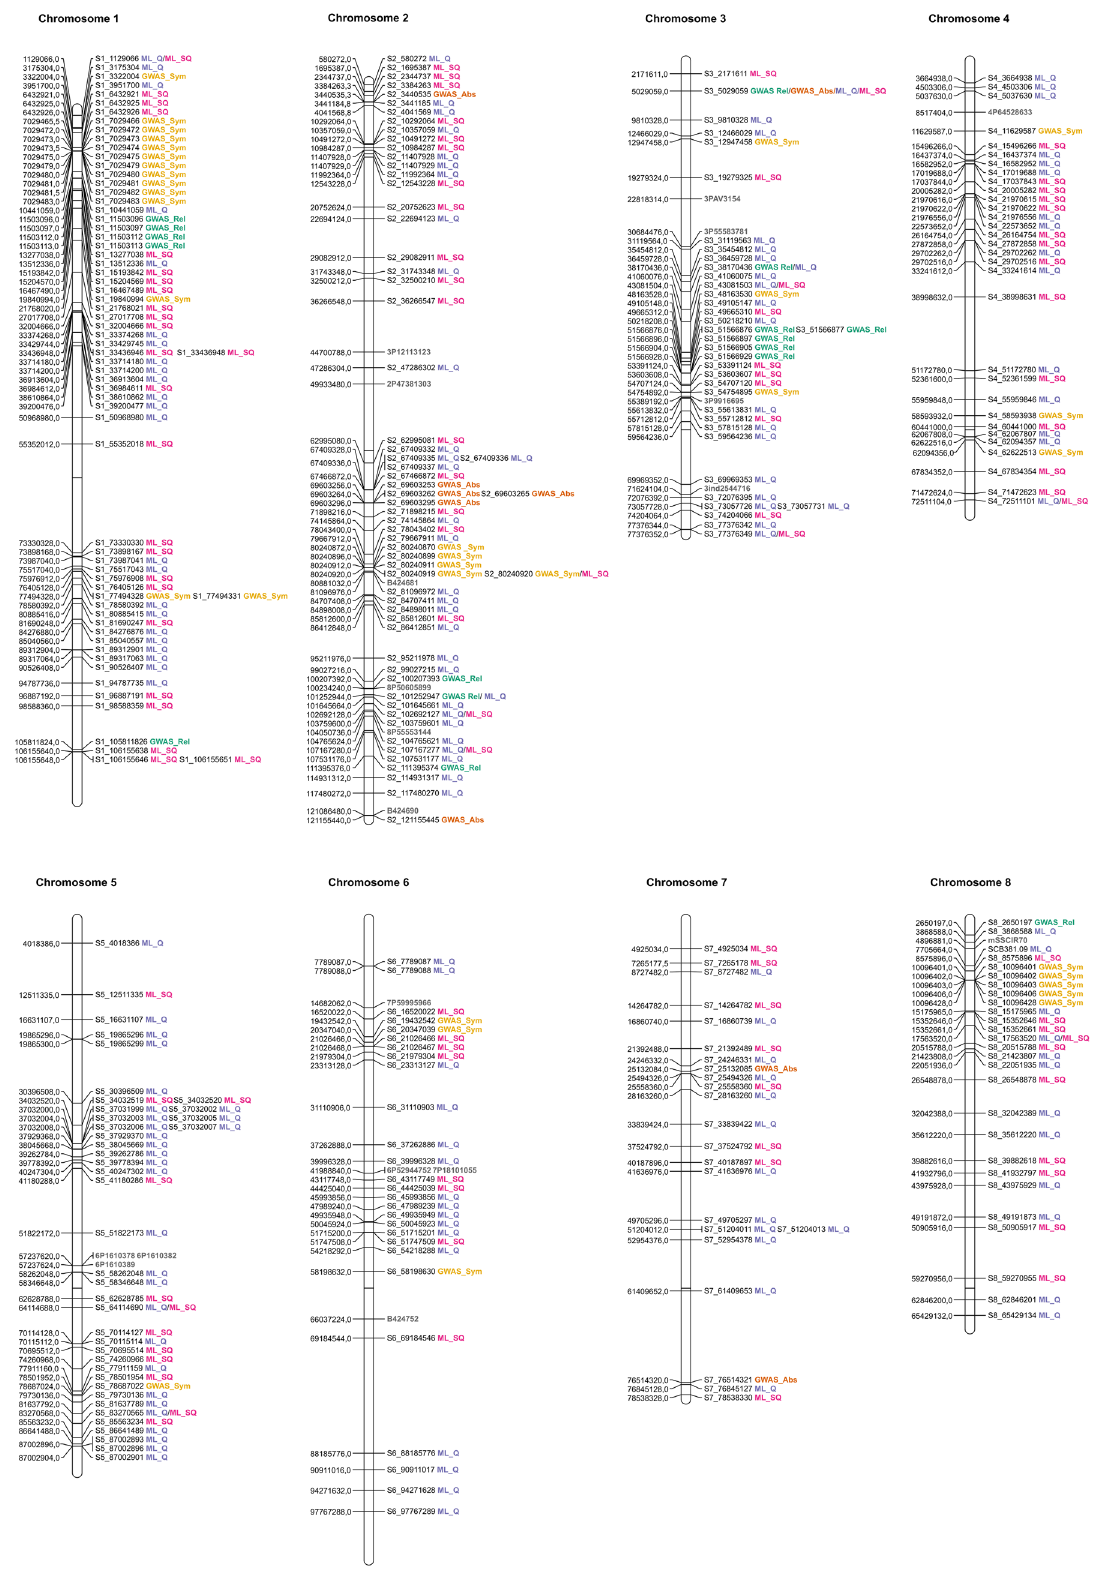
Figure 5. Distribution of markers associated with SCYLV resistance along Saccharum spontaneum “A” chromosomes. In each chromosome, marker positions are shown on the left, and marker names are indicated on the right, labeled and colored according to the method employed for their identification. Markers identified by previous mapping studies are colored in